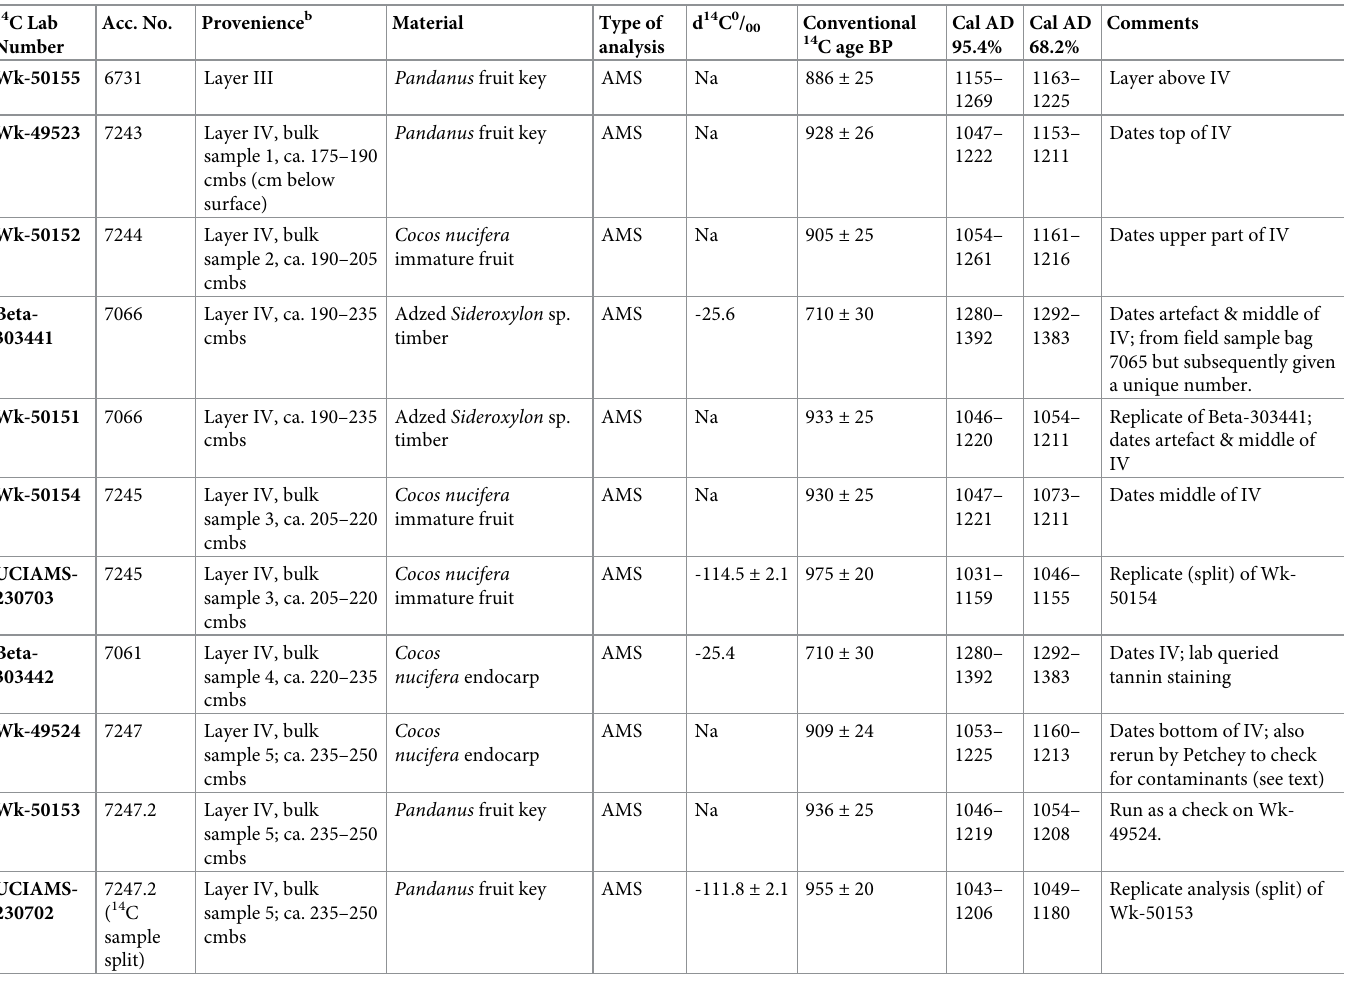
Table 2. Trench 1, Ho‘oumi Beach (Nuku Hiva Island) radiocarbon sample details, analytic results, and calibrations a